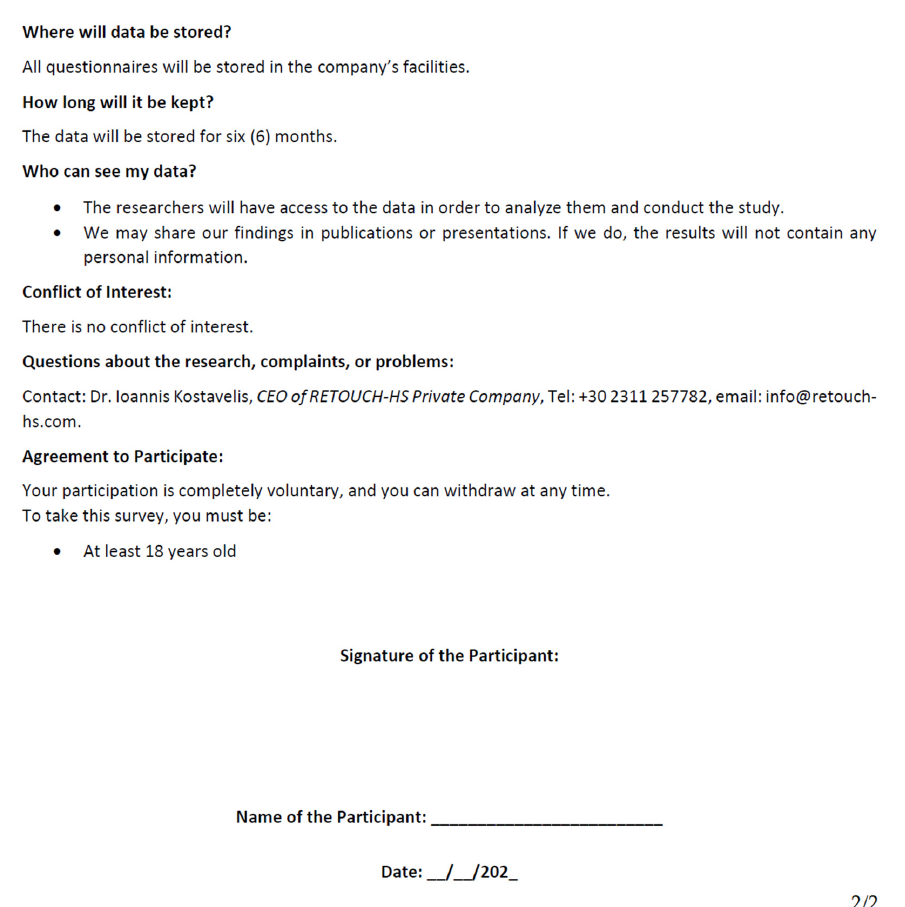
Figure A2. The second and last page of the informed consent form.